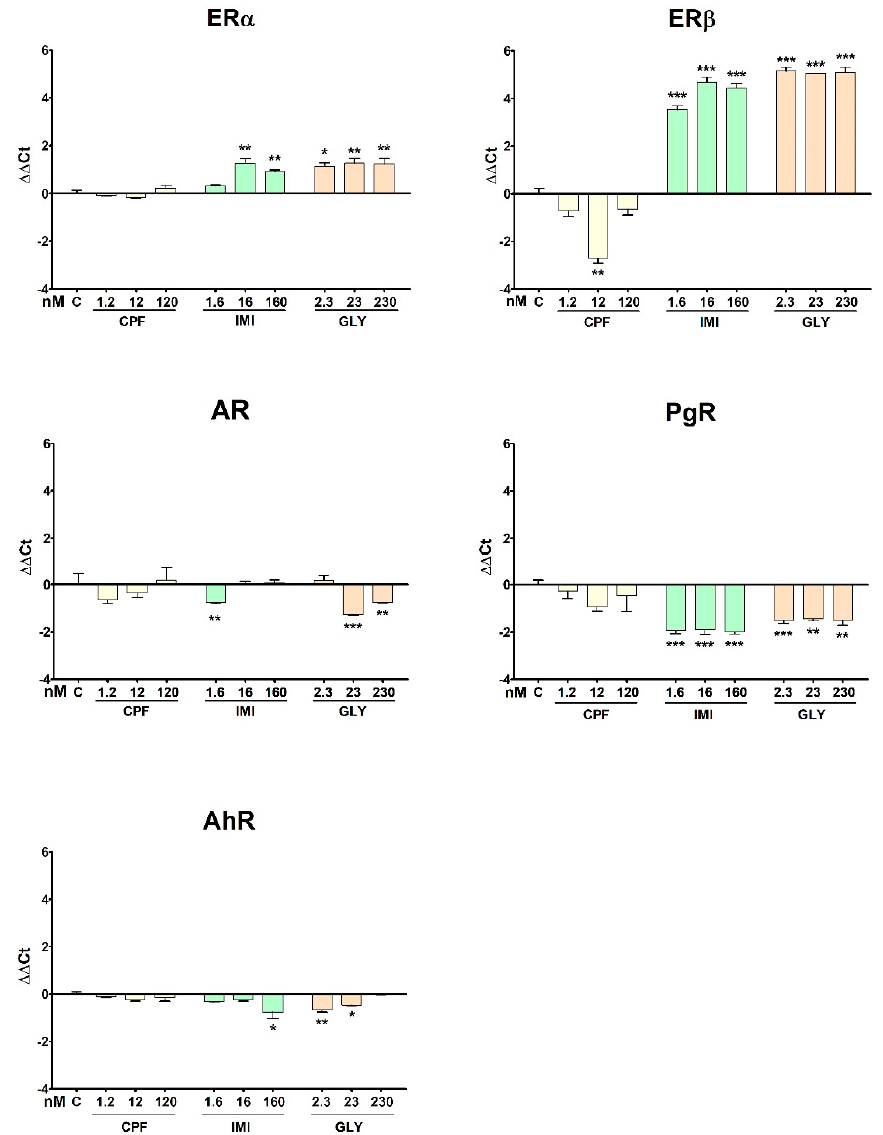
Figure 8. Gene expression levels of a panel of nuclear receptors assessed in MCF-12A cells following treatment with CPF, IMI and GLY for 72 h. Data are mean ∆∆ Ct values ± SEM of three independent experiments, with control samples as calibrators and the geometric mean of GAPDH and ACTB as reference. Asterisks indicate statistically significant differences with respect to control cells: * p < 0.05; ** p < 0.01; *** p < 0.001.